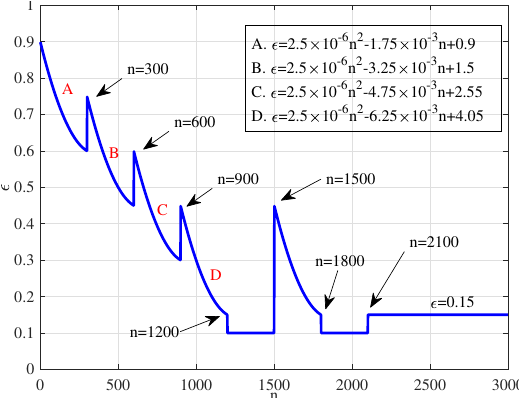
Figure 6. Relationship between episode n and exploration probability (cid:101)